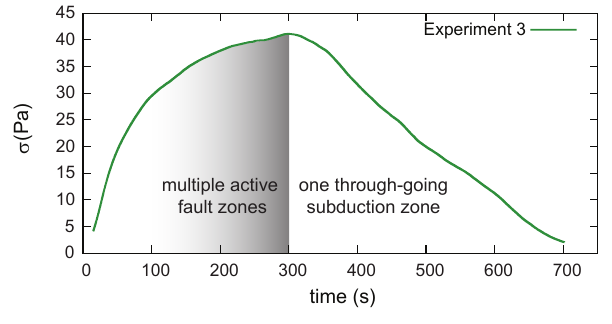
Fig. 13. Convergence parallel normal stress recorded in the back of the overriding plate in Experiment 3. The stress keeps increasing at the beginning of the experiment despite the formation of multiple shear zones. The stress decreases only once one shear zone becomes through-going. Strain is then localized into this zone (see Fig. 11b) and stress